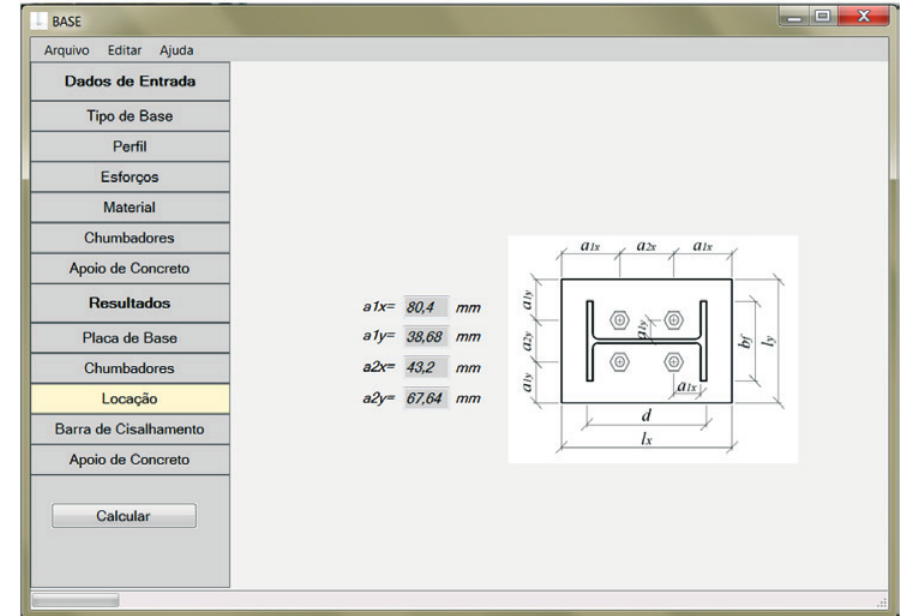
Figura 14 Janela de dados de saída de locação dos chumbadores